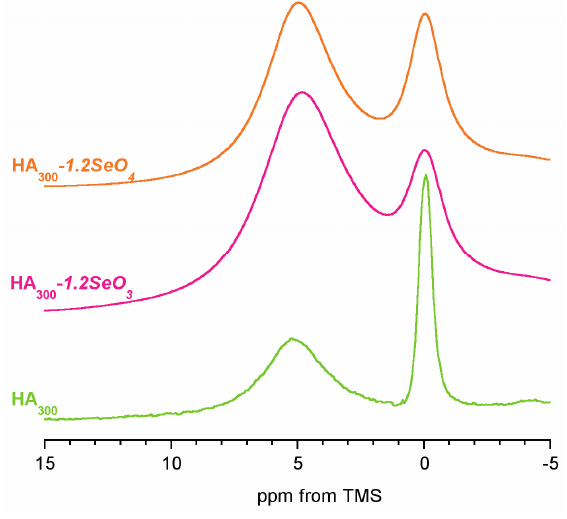
Figure 4. The 1 H BD NMR spectra of HA 300 , HA 300 -1.2SeO 3 and HA 300 -1.2SeO 4 .